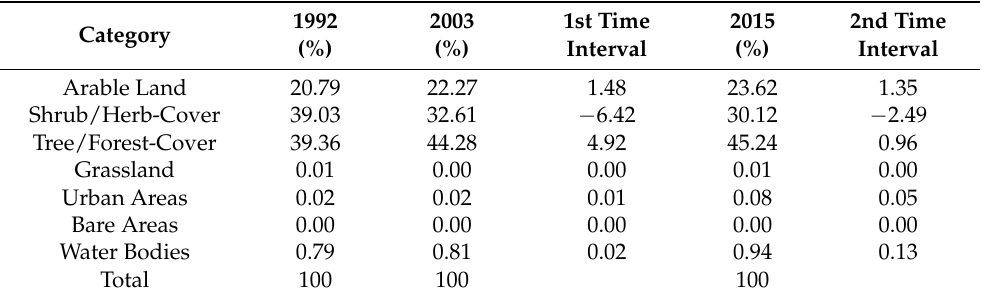
Table 1. Land-cover proportions of the study area in 1992, 2003, and 2015 and the changes in land-cover proportions during the two time